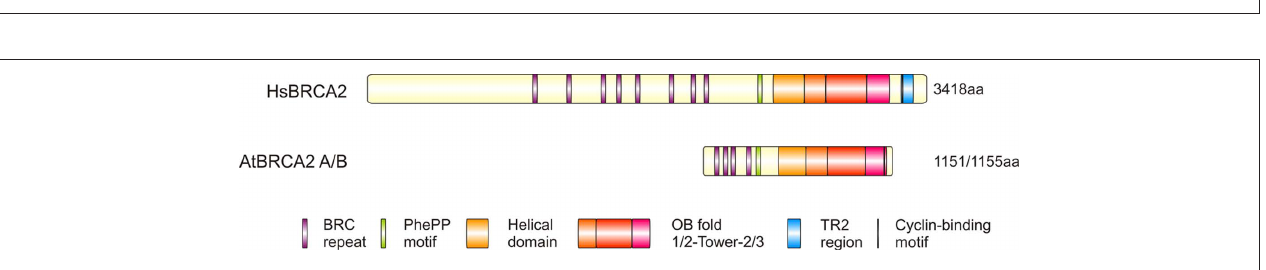
FiguRe 7 | Structure of human and Arabidopsis BRCA2. The human BRCA2 and the two Arabidopsis BRCA2 proteins differ in terms of their length (3418 aa compared to 1151/1155 aa). Despite that difference, almost all the important domains of the human protein are conserved in plants. The only exceptions are the missing TR2 region and the reduced amount of BRC repeats in Arabidopsis . (OB, oligonucleotide binding; TR2, terminal